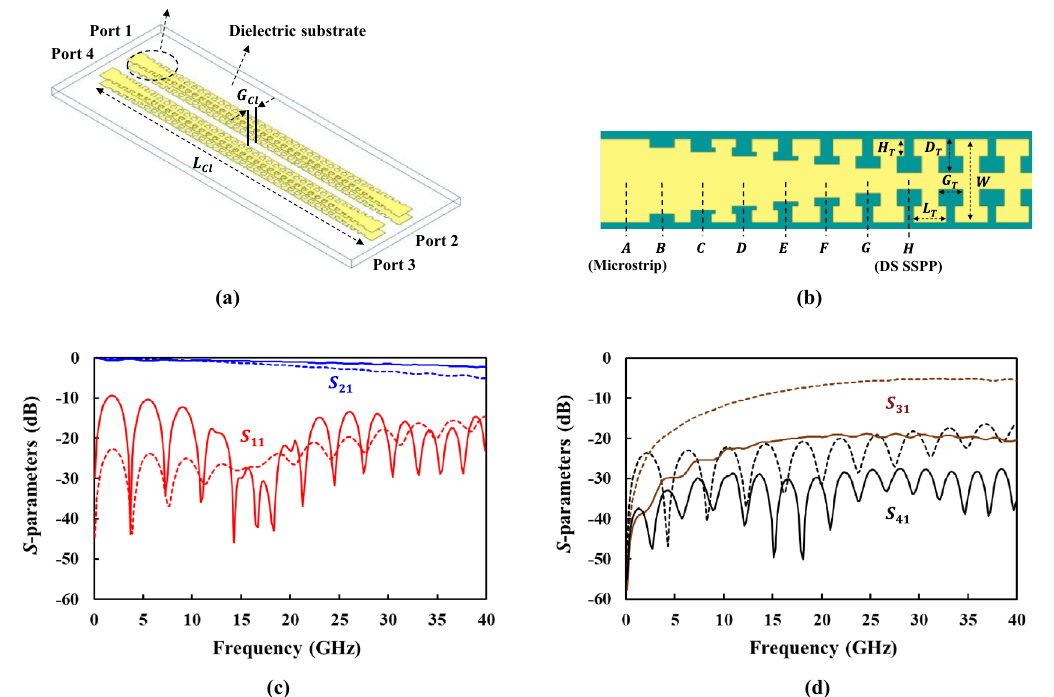
Figure 5. Coupled transmission lines and simulated S -parameters in microstrip (slotted) and DS SSPP (solid). ( a ) DS SSPP coupled lines. ( b ) Microstrip-to-DS SSPP transition in which H T = 0.20 mm, D T = 0.40 mm, G T = 0.30 mm, L T = 0.40 mm, and W = 1.00 mm. ( c ) Simulated insertion and return losses. ( d ) Simulated coupling ( | S 31 | ) and isolation ( | S 41 |